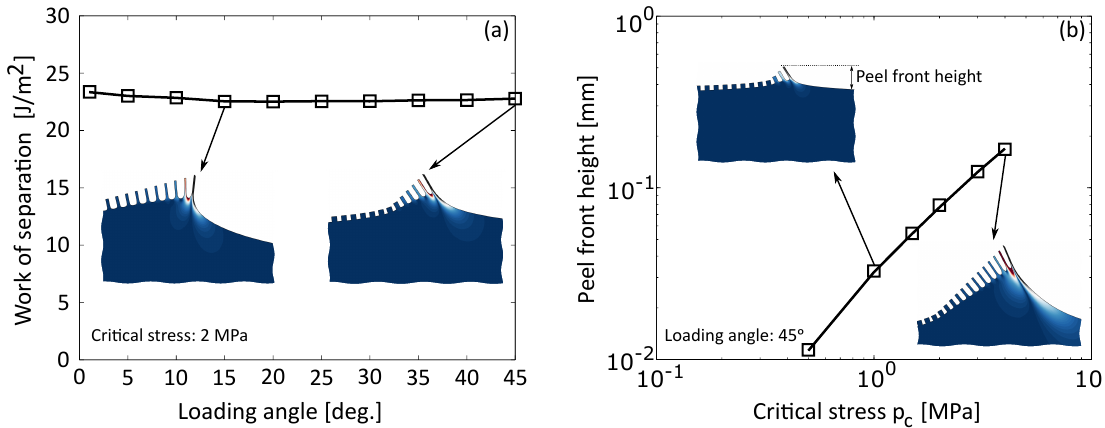
Figure 6. ( a ) WOS as function of loading angle, with the insets showing deformed geometries for two loading angles 15 ◦ and 45 ◦ at p c = 2.0 MPa (the colours indicate the strain energy density (SED, (N/mm 2 )) after failure minus the SED before failure, projected on the geometry before failure). The WOS is not significantly influenced by the loading angle; ( b ) peel front height as function of critical stress, with the insets showing deformed geometries for two critical stress values p c = 1.0 MPa and p c = 4.0 MPa at a loading angle of 45 ◦ . The critical stress has a significant influence on the peel front height and the WOS